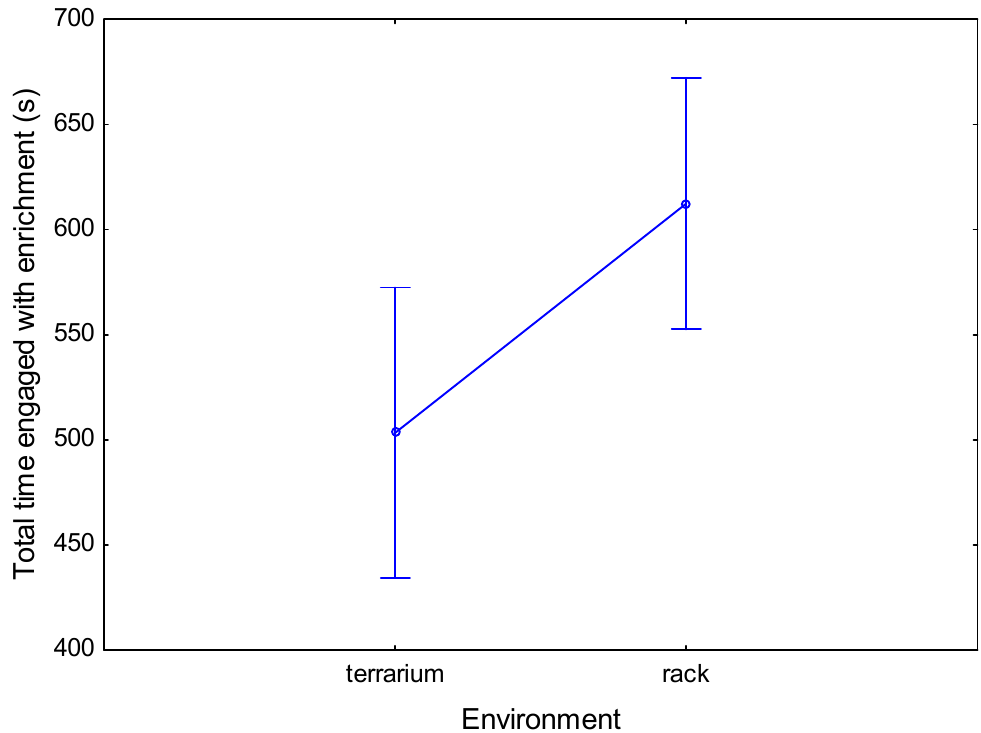
Figure 5. Mean total contact time (s) with the enrichment in both environments, without dividing by the enrichment type (vertical bars denote 0.95 con fi dence intervals, Tmax = 2700 s). No signi fi cant di ff erences were detected between repetitions (repeated measures